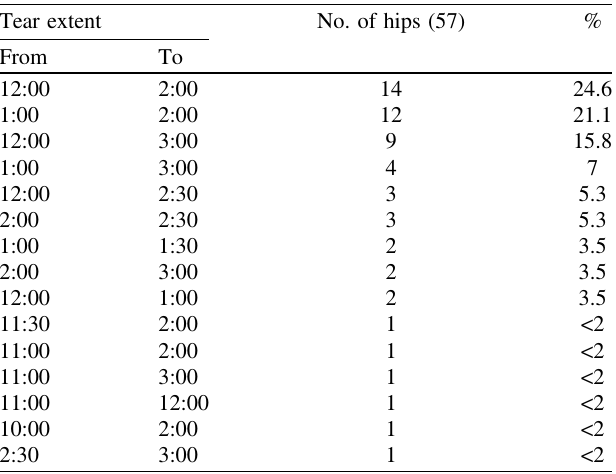
Table 5. Overall pre- and postoperative Alpha angle and fi nal follow-up PROMs.